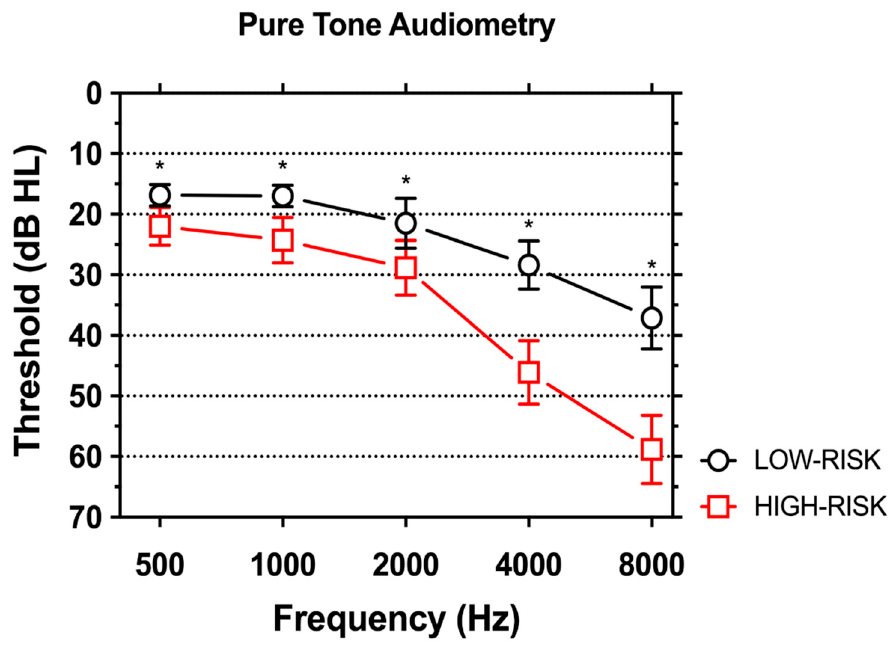
Figure 1. Pure tone audiometry in the LOW-RISK and HIGH-RISK groups. Means ± 95 CI are shown. A statistically-significant worse auditory threshold was found for individuals in the HIGH-RISK group. Asterisks indicate statistically-significant differences. HL, hearing loss.